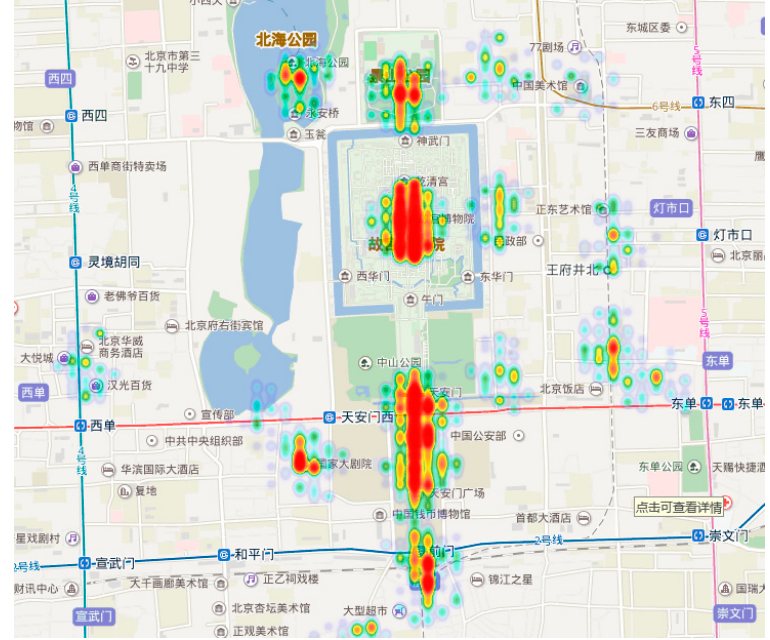
Figure 7. Heat map of the attractions in Tiananmen Square and its surrounding area.